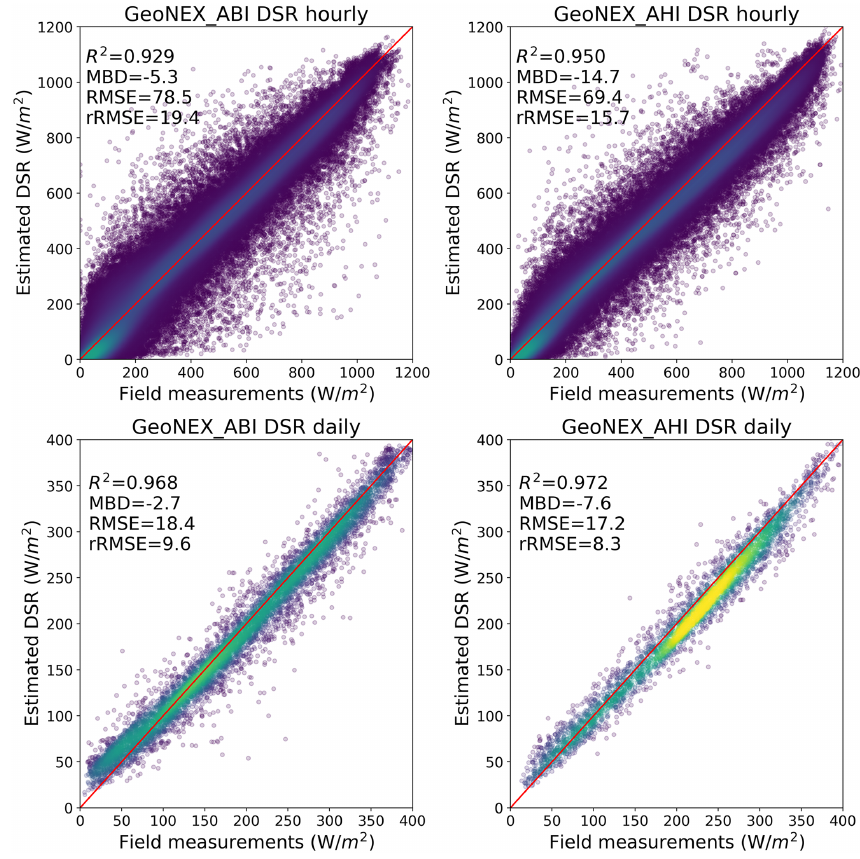
Figure 4. Scatter plots of the estimated and observed daily and hourly DSR values for ABI and AHI data.